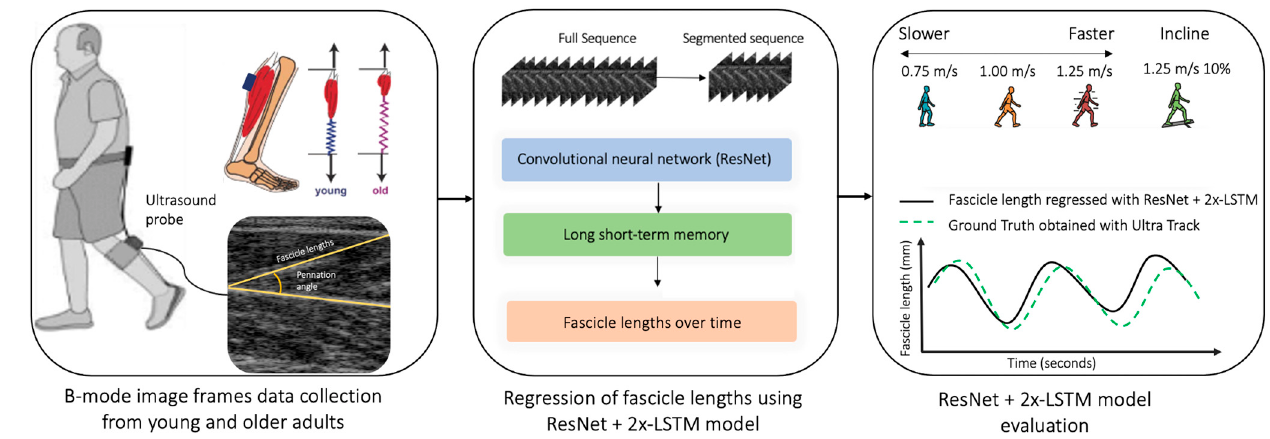
Figure 1. The proposed study where an ultrasound probe is placed over the medial gastrocnemius muscles, the proposed ResNet + 2x-LSTM architecture extracts the fascicles, and then the perfor- mances of the model are evaluated across different walking speeds of 0.75, 1.25, and 1.5 m/s and tasks (level ground and incline).